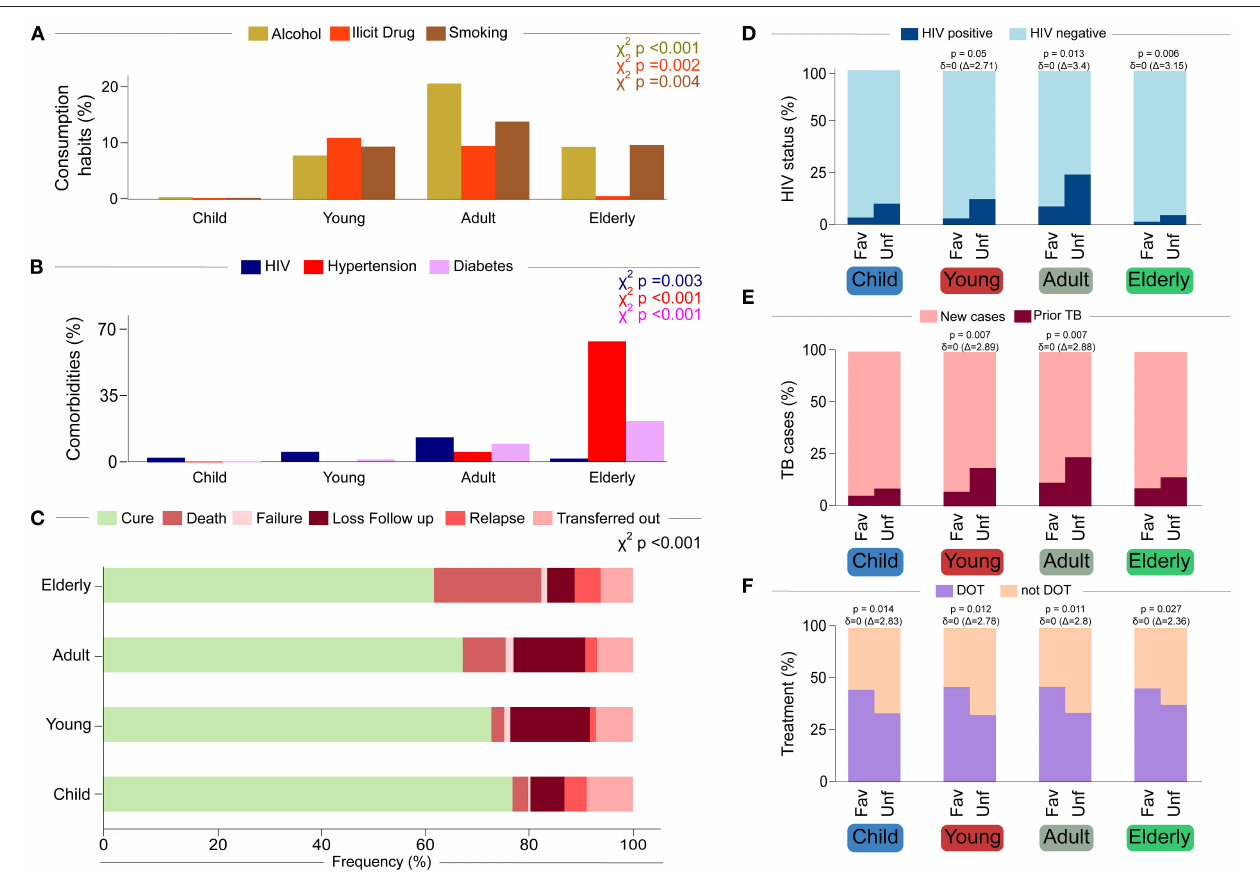
FIGURE 2 | Characteristics of each age group (A–C) and outcome category (D–F) . (A) Consumption habits, we observed that young people and adults have greater consumption habits of alcohol, cigarettes, and illegal drugs than children and the elderly. (B) Comorbidities, while adults have a higher prevalence of HIV. The elderly has a higher prevalence of diabetes and hypertension. (C) Outcome description. The frequency of favorable outcome (cure) decreases according to age, being higher in children and lower in the elderly. (D) HIV status. Positive serology for HIV infection is correlated with an unfavorable treatment outcome in young, adults, and elderly. (E) TB Status. Relapse cases of TB are correlated with an unfavorable treatment outcome in young and adults. (F) Observed Treatment. In all age groups, receive a DOT is correlated with a favorable treatment outcome. Age Groups: Children (0–9.9 years); young (10–24.9 years); Adults (25–64.9 years); Elderly( ≥ 65